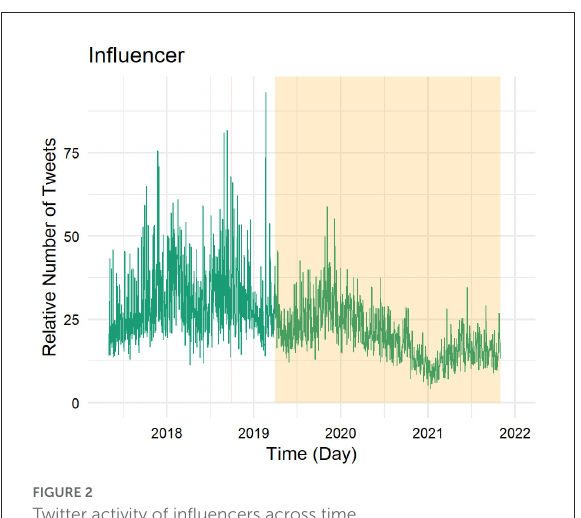
FIGURE2 Twitter activity of influencers across